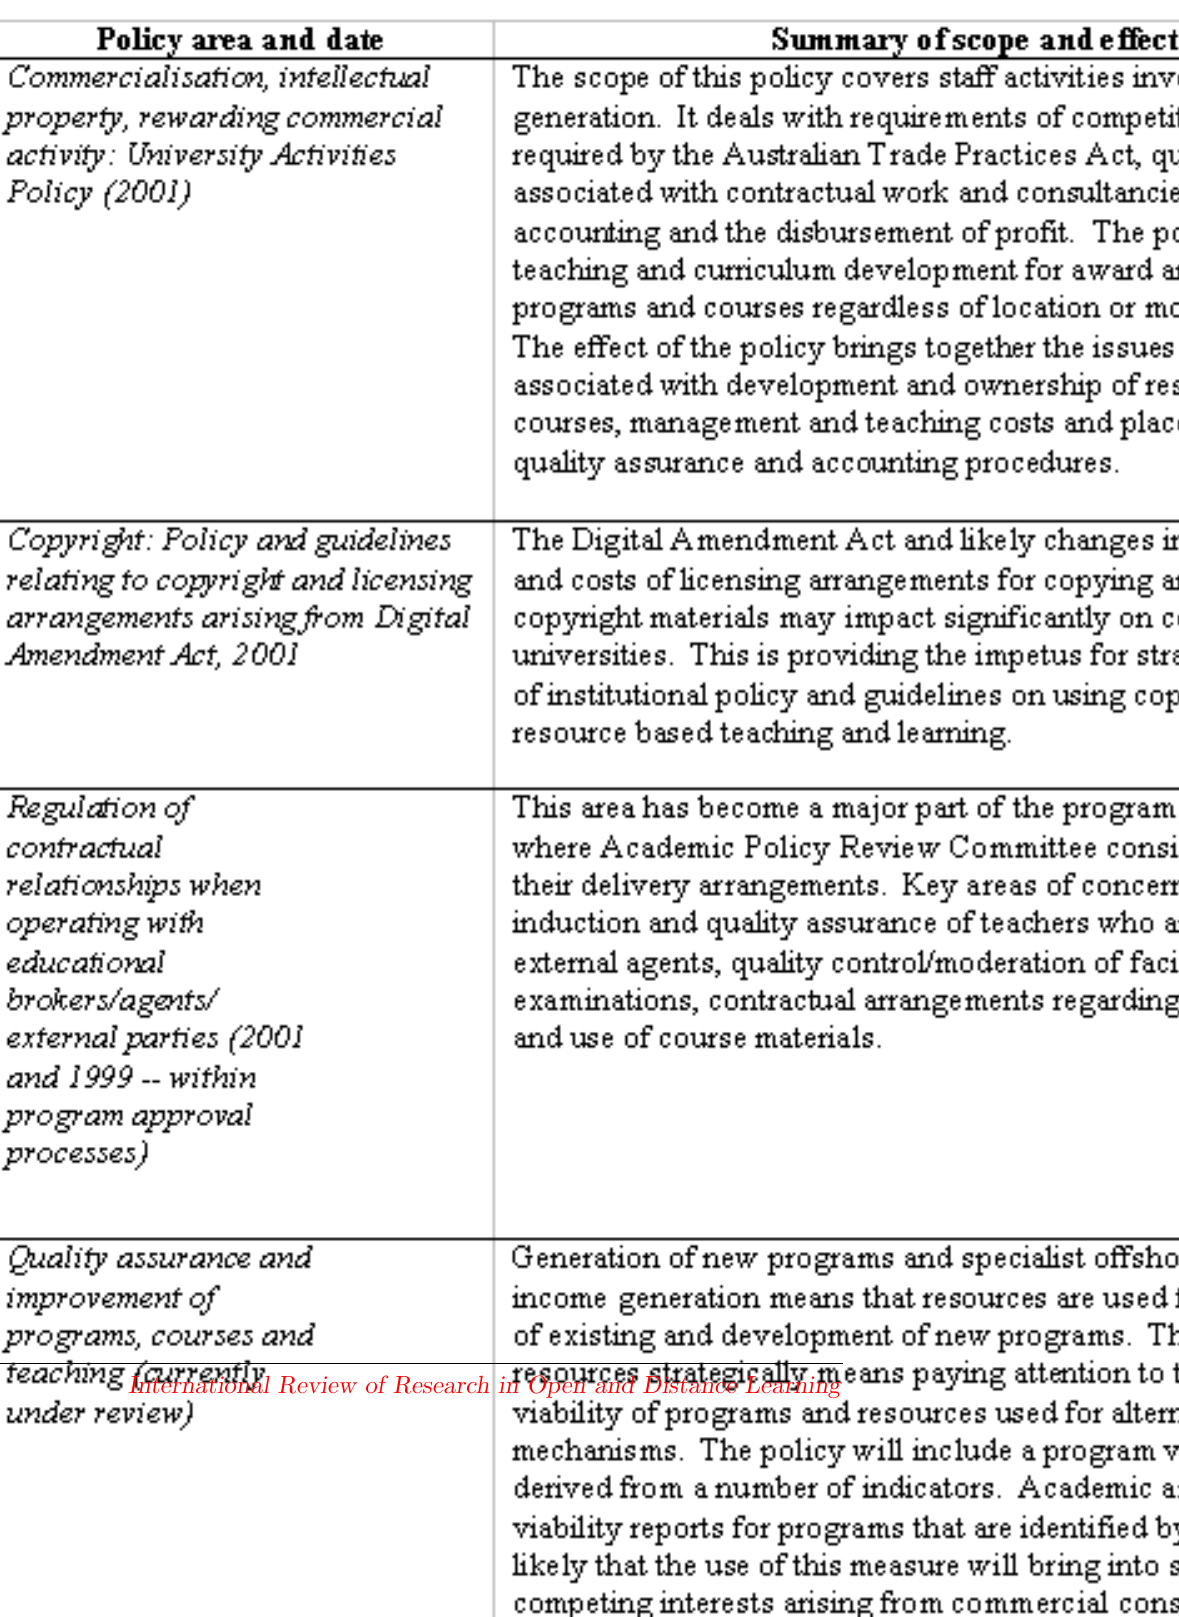
International Review of Research in Open and Distance